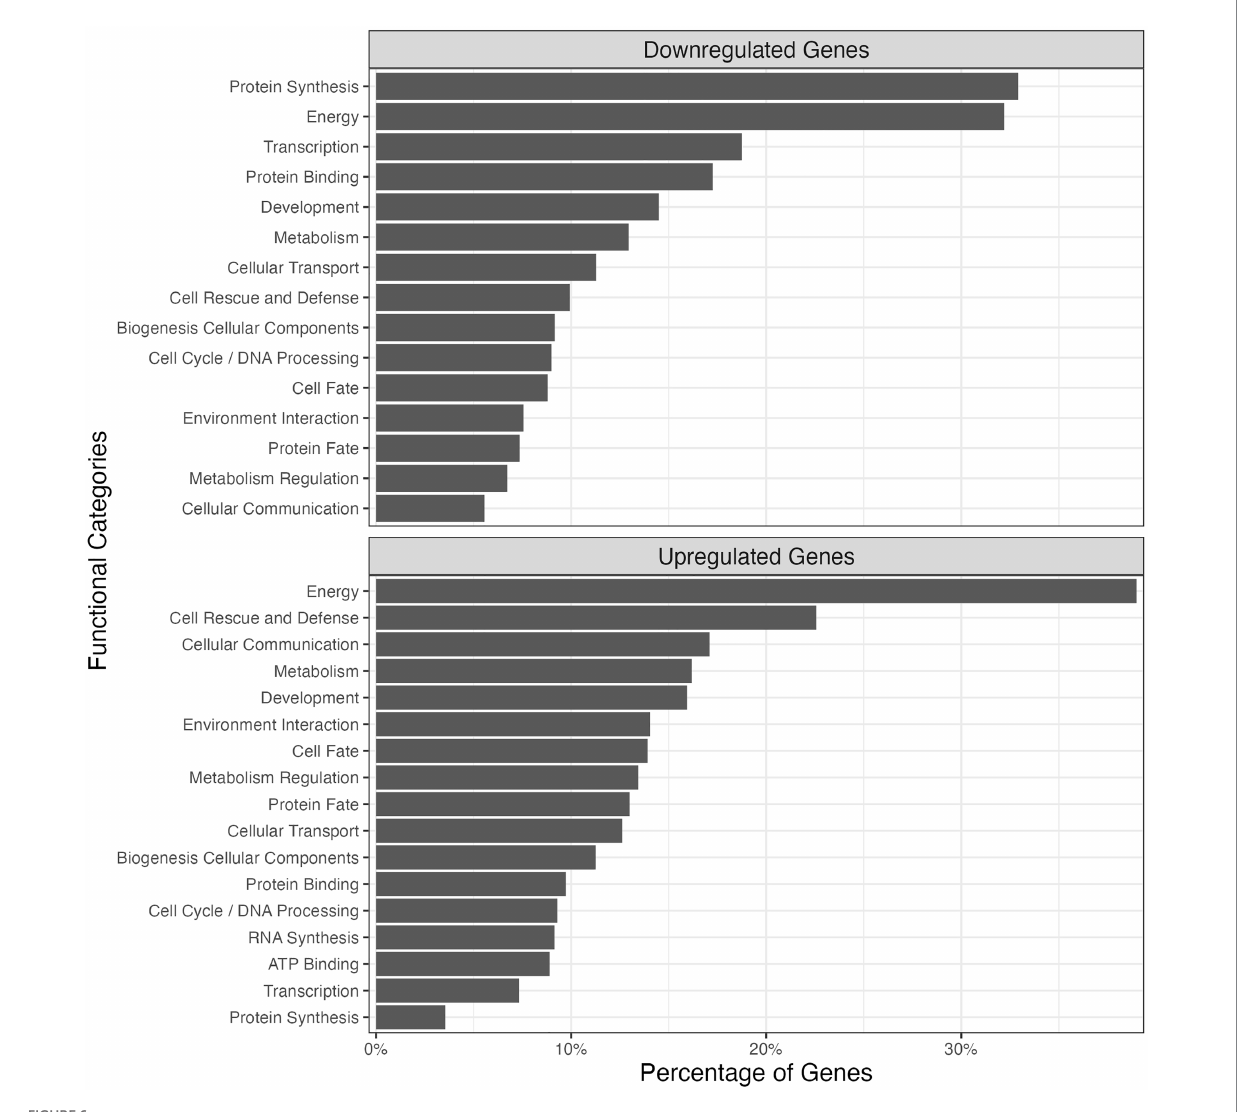
FIGURE 6 Functional categories and the corresponding percentages of the number of involved upregulated/downregulated genes of C9 among the total number of genes found in each functional category. The functional category annotation and gene clustering were performed using the FunCat